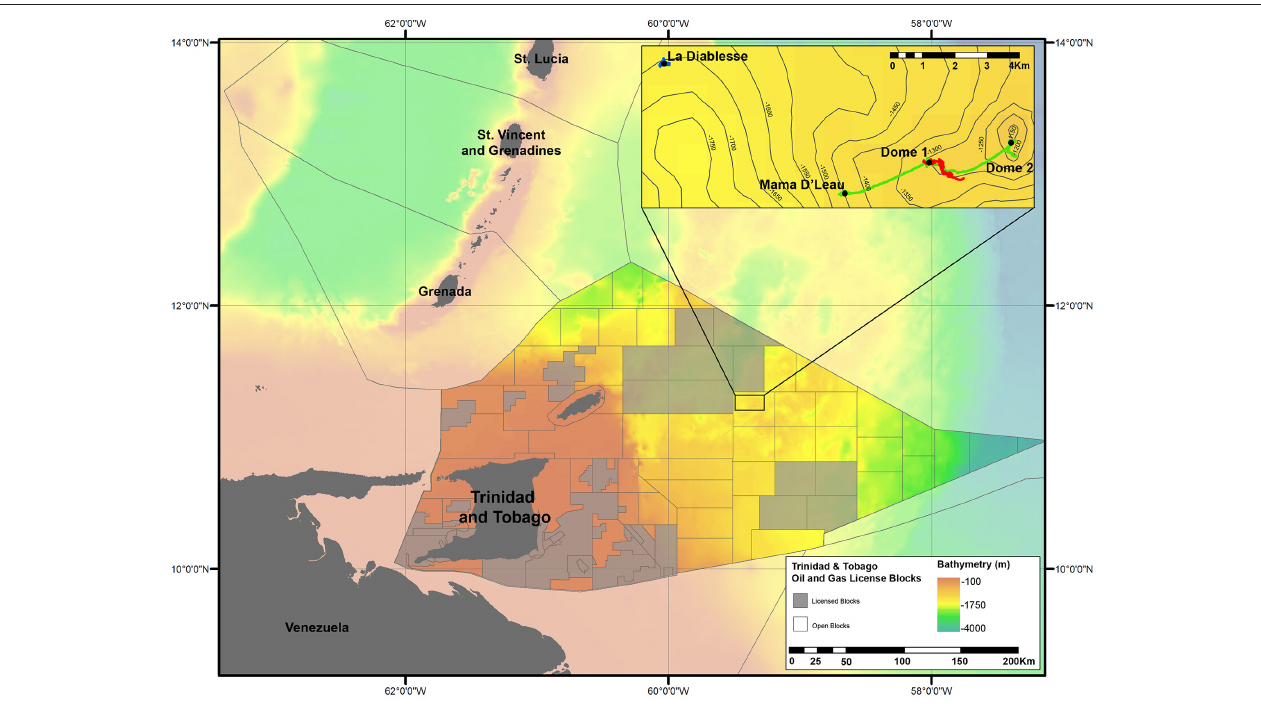
FIGURE 1 | Locations of the four methane seep sites surveyed at El Pilar off Trinidad and Tobago during NA054. Gray lines denote Exclusive Economic Zones (EEZs) in the main map. Within the Trinidad and Tobago EEZ, oil and gas lease blocks can be seen. The blocks that have been leased are colored transparent gray. ROV dives tracks can be seen in the inset map: green = Dive H1392, red = Dive H1393, and blue = Dive H1394. Seep sites are indicated by black circles and the site name. Lease blocks were adapted from a map by the Ministry of Energy and Energy Affairs, Government of the Republic of Trinidad and Tobago. Gridded bathymetric data provided by the General Bathymetric Chart of the Oceans (GEBCO) 30 arc-second grid (accessed via http://www.gebco.net/). Map and associated shapefiles created in ESRI ArcMap (version